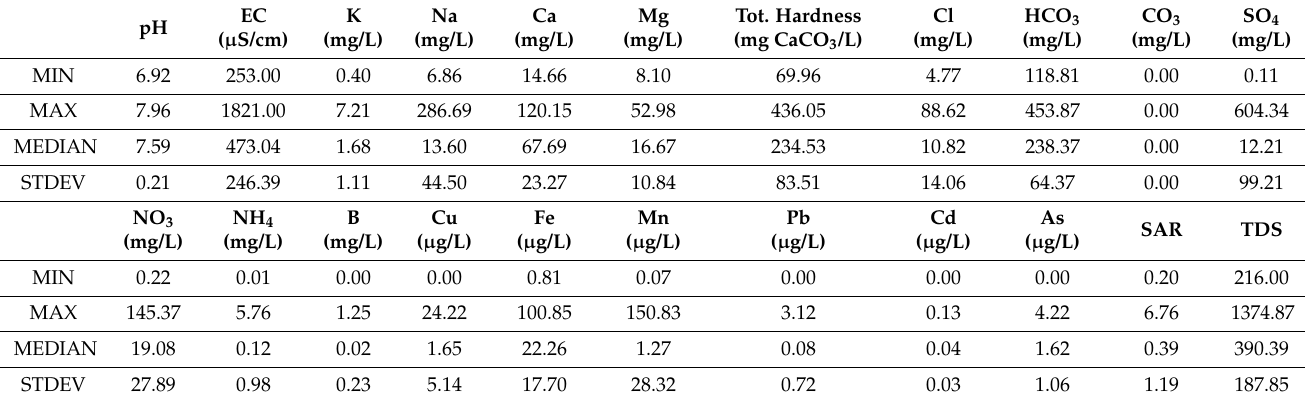
Table A1. Basic descriptive statistics of analyzed